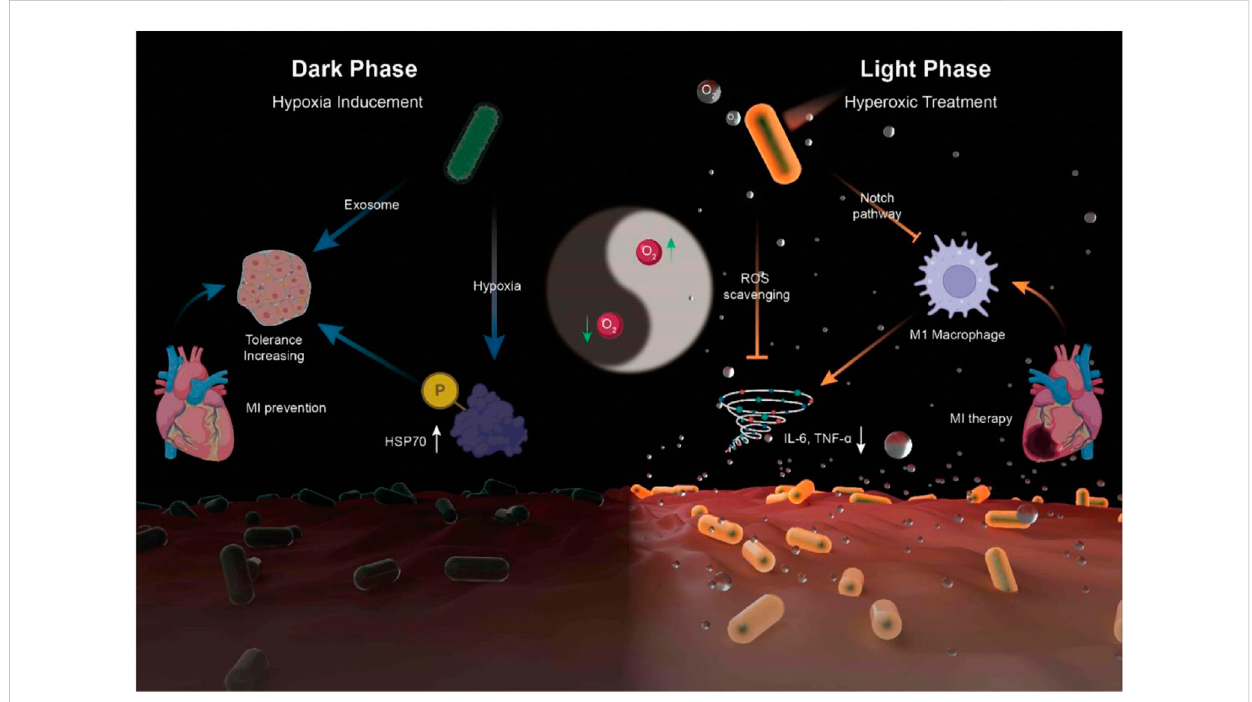
FIGURE 9 Synthesis of UCCy@Gel for acute MI prevention (dark phase) and therapy (light phase):the UCCy@Gel consumesoxygen via respiration to generate a hypoxic microenvironment, resulting in the upregulation of HSP70, which enhanced the tolerance of CMs for MI (left); Under 980 nm NIR irradiation, the UCCy@Gel releases photosynthetic oxygen through UCL to inhibit macrophage M1 polarization and downregulated proin fl ammatory cytokines IL-6 and TNF- α to repair myocardial injury (right) (Liu Y. et al.,